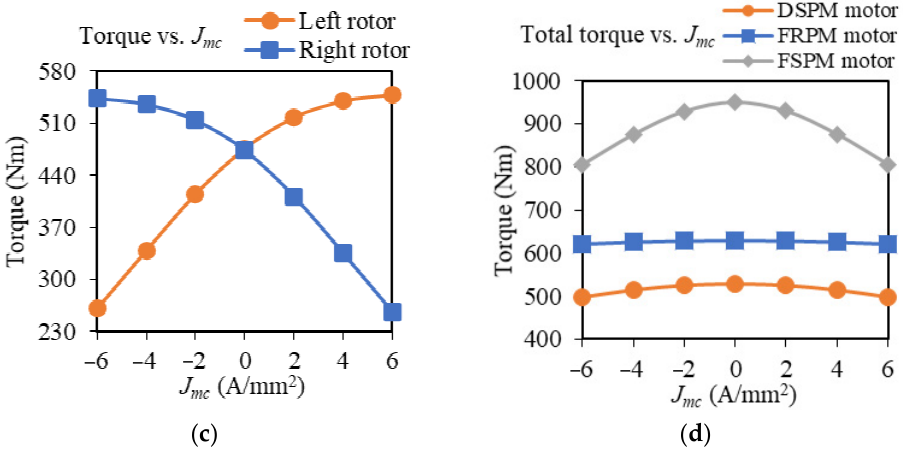
Figure 7. Torque performances of three AF-DR motors under different MC current densities: ( a ) DSPM, ( b ) FRPM, ( c ) FSPM, ( d ) total torque.